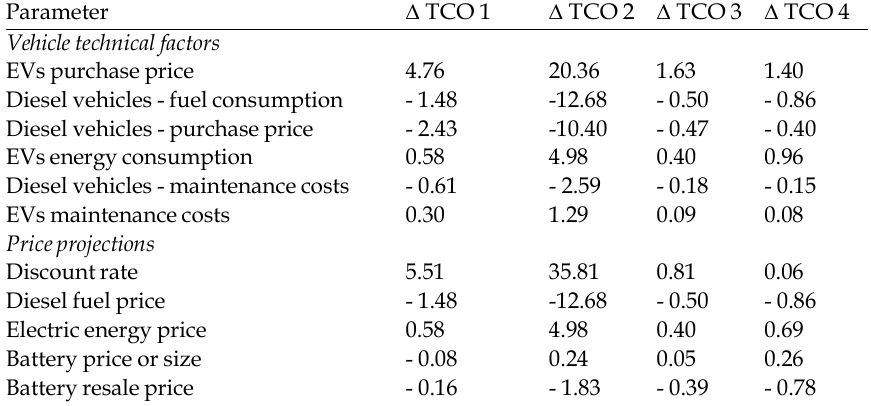
Table 6. Per kilometre discounted cost elasticity factors